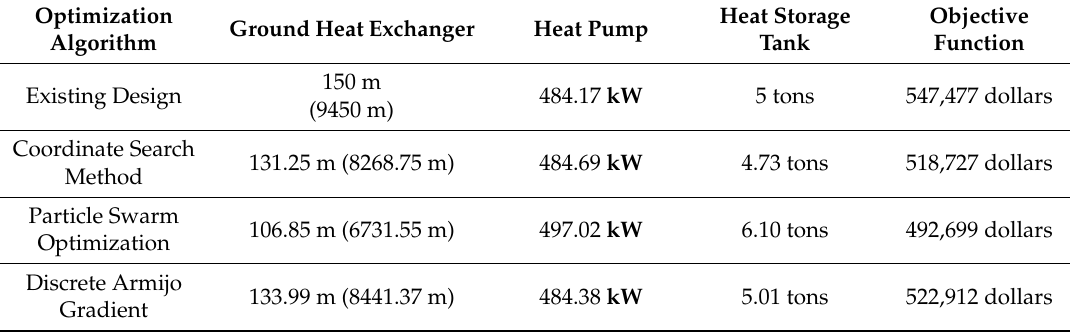
Table 7. Optimization results for the 20-year operating